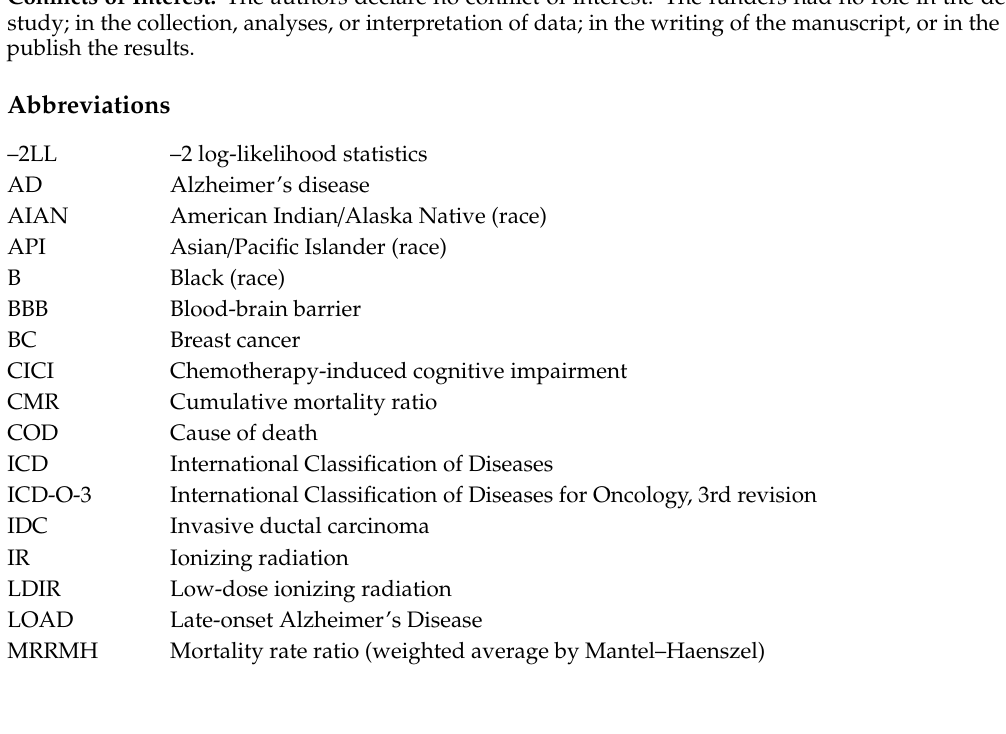
Table S7: Risk of AD death in breast cancer patients relative to the reference population stratified by radiotherapy status; Table S8: Cohort characteristics of breast cancer patients from SEER 9 registry included in the analysis of the influence of radiotherapy, chemotherapy and demographic / clinical variables on the Alzheimer’s disease death rate; Table S9: Status of strata in Cox model of AD death hazard in women diagnosed with breast cancer at 45 + years of age; Table S10: Status of variable in Cox model of AD death hazard in women diagnosed with breast cancer at 45 + years of age; Table S11: Test for proportionality of hazards violation for the Cox model of AD death hazard in women diagnosed with breast cancer at 45 + years of age; Figure S1: Cumulative hazards ratio of AD death between age groups 5 (85 + years) and 3 (65–74 years); Figure S2: Baseline cumulative hazards of AD death in patients diagnosed with breast cancer at 45 + years versus time since cancer diagnosis, stratified by race; Figures S3–S7: Log( − log survival) curves for AD death in women diagnosed with breast cancer at 45 + years. Cox model with variable race stratified on five 10-year age groups; Figure S8: Baseline cumulative hazard curves for AD death in white women diagnosed with breast cancer at 45 + years. Cox model stratified on chemotherapy status; Figure S9: Log( − log survival) curves for AD death in white women diagnosed with breast cancer at 45 + years. Cox model stratified on chemotherapy status; Figure S10: Baseline cumulative hazard curves for AD death in white women diagnosed with breast cancer at 45 + years. Cox model stratified on radiotherapy status; Figure S11: Log( − log survival) curves for AD death in white women diagnosed with breast cancer at 45 + years. Cox model stratified on radiotherapy status; Figure S12: Cumulative AD mortality ratios (CMRs) for beam radiotherapy versus no / unknown radiation therapy